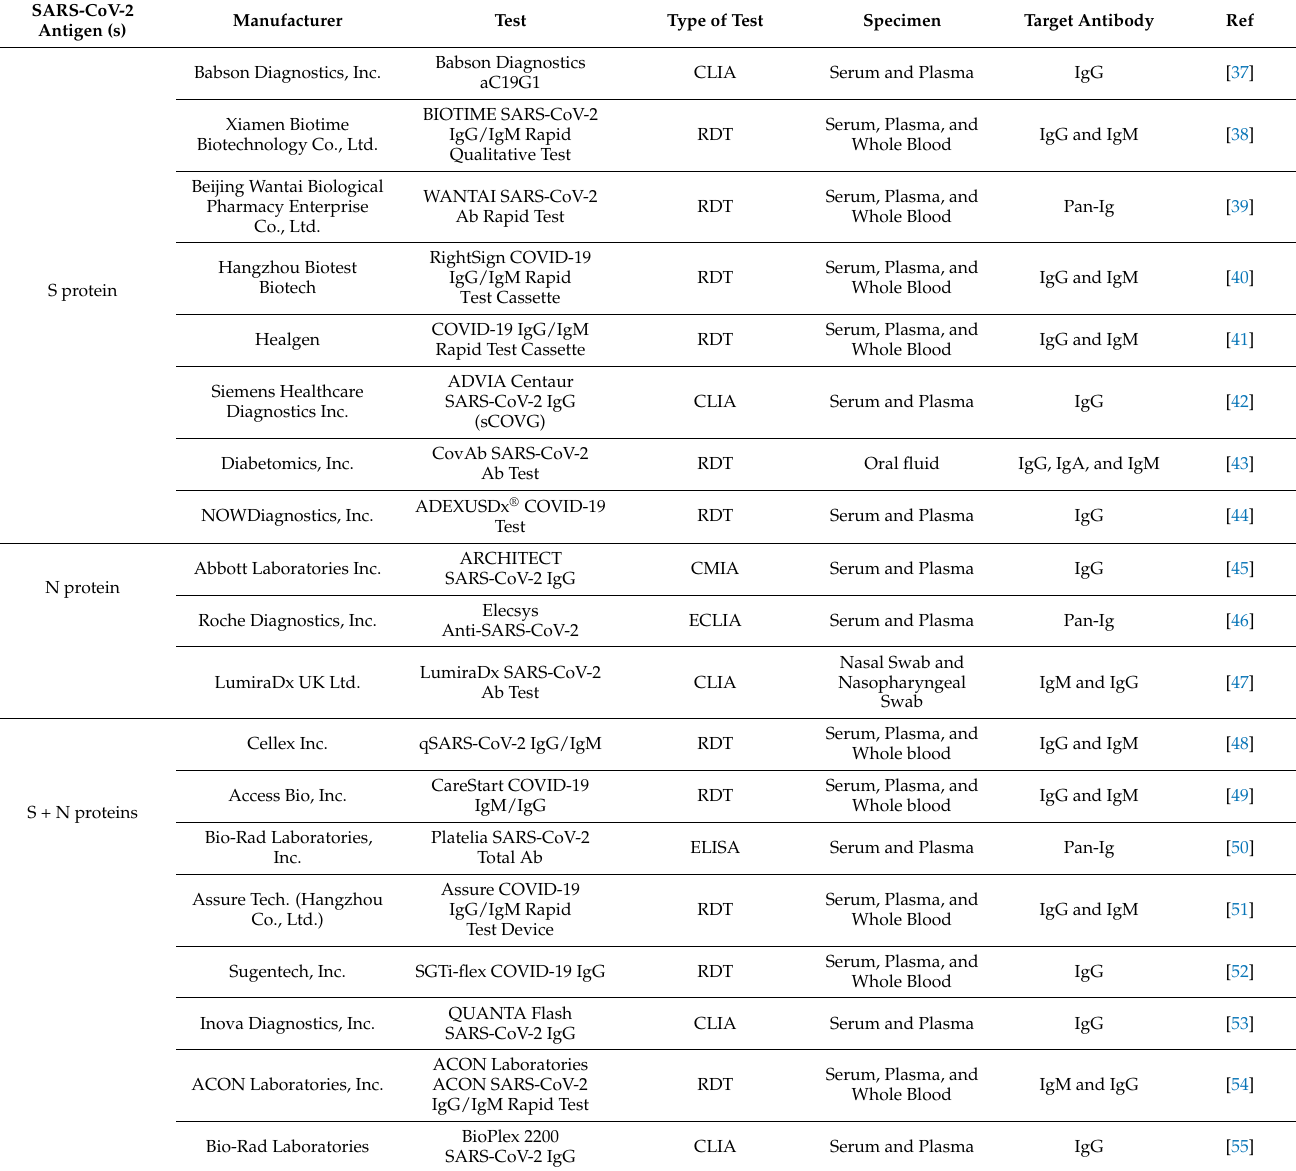
Table 1. Characteristic data of different COVID-19 serological assays that employ S and/or M